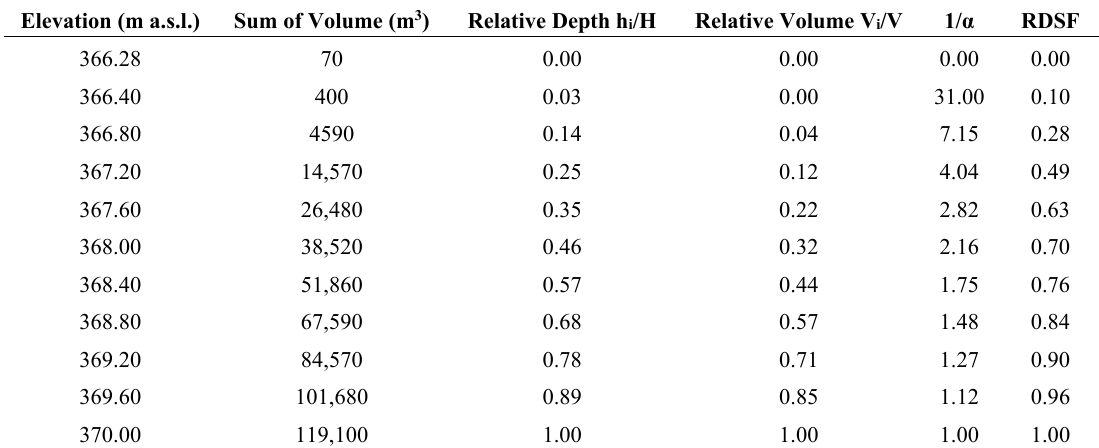
Table 7. Relative Depth Shape Function for different elevations from the reservoir bed for Krempna reservoir before